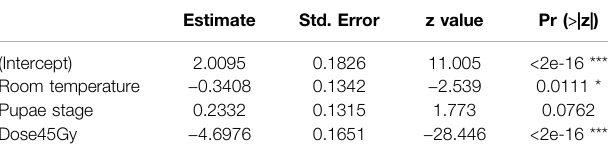
TABLE 1 | Fixed effects of chilling on pupae and adult radiosensitivity.